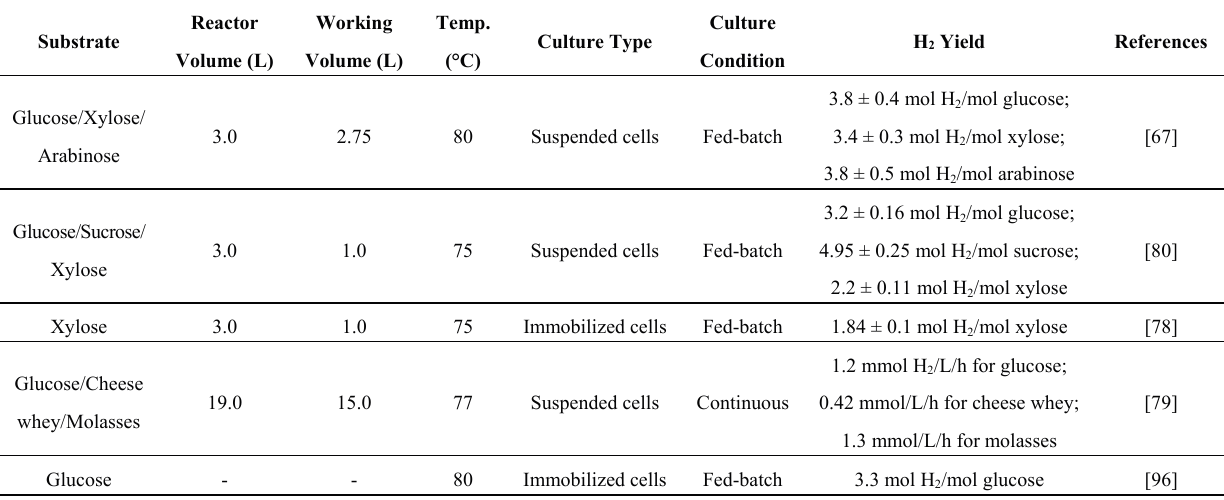
Table 2. Continuous and fed-batch operation in CSTRs for T. neapolitana